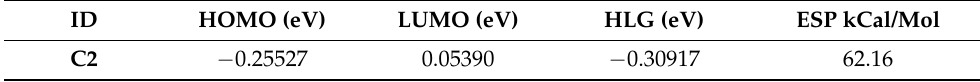
Table 1. Theoretical electrostatic parameters of the